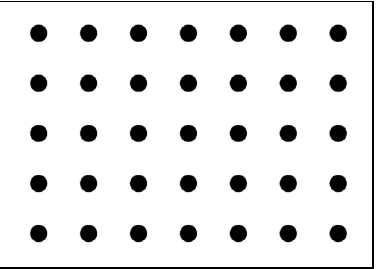
Figure 11. Grid of circles printed and used for the camera calibration.